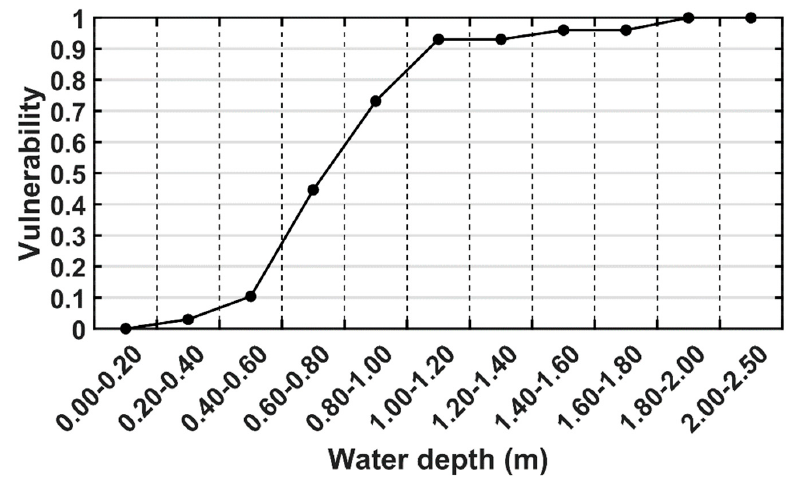
Figure 3. Vulnerability for type I housing. Adapted from [36]. Table 1. Characteristics of each type of housing and the value assigned to its associated household goods Type of